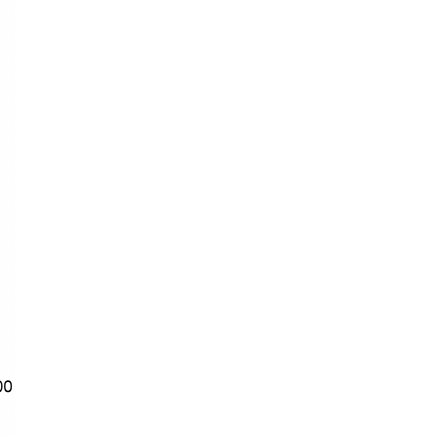
Figure 14. The mass displacement behaviour illustrating the effect of SMA devices on the right and left sides.